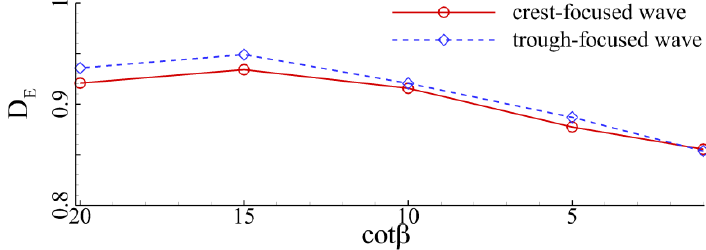
Figure 53. Wave energy dissipation rate versus the backreef slope.